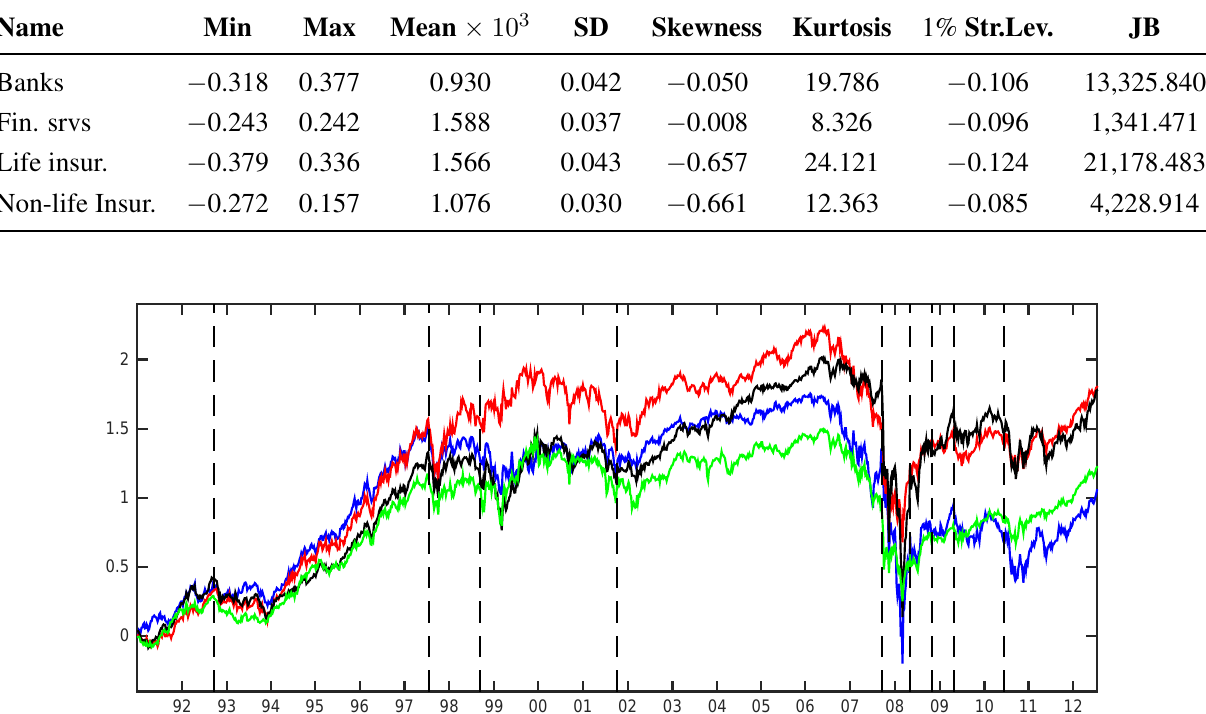
Figure 1. Cumulative returns of the different sectors: banks (blue line), financial services (red line), life insurance (dark line) and non-life insurance (green line). Vertical dotted lines represent major financial downturns: see Figure 1 for a detailed